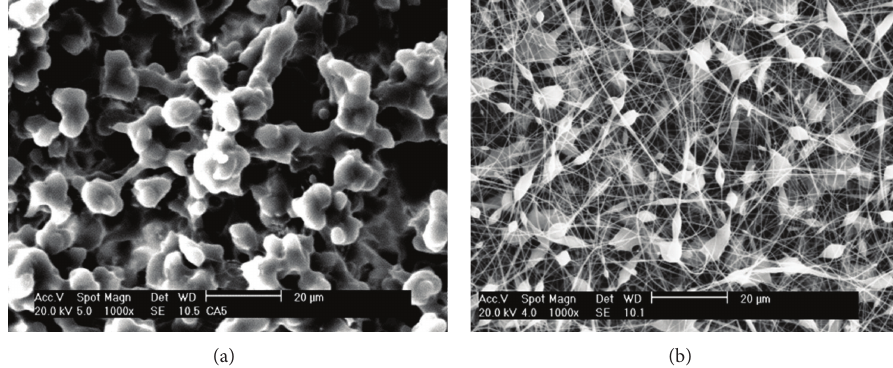
Figure 4: SEM micrographs showing the effect of binary solvent systems on resulting CA electrospun fibre morphology and web structure at a polymer concentration of 15% (w/v). Mag 300x: (a) DMAc:acetone (2:1) large beads, (b) acetone :DMAc (2: 1) fibres and small